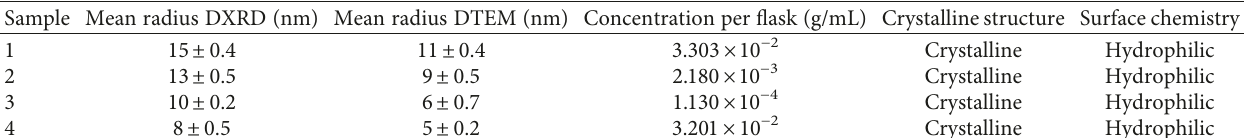
Table 2: Characteristics of the CeGdZn-ferrite inorganic nanoparticles used in experimentation.